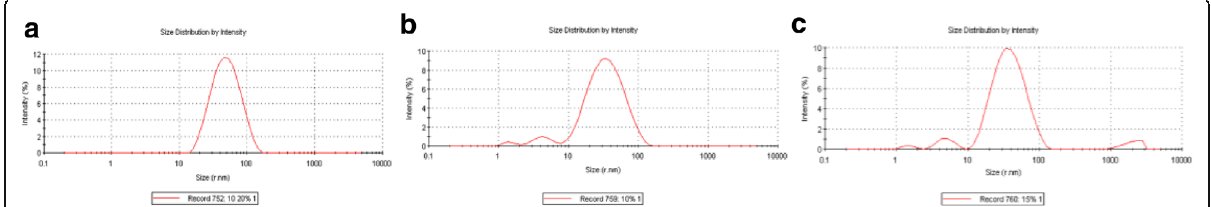
Fig. 8 Particle size distribution of AgNP solution synthesized by Trichoderma longibrachiatum for a 10 g fungal biomass at 20% dilution,